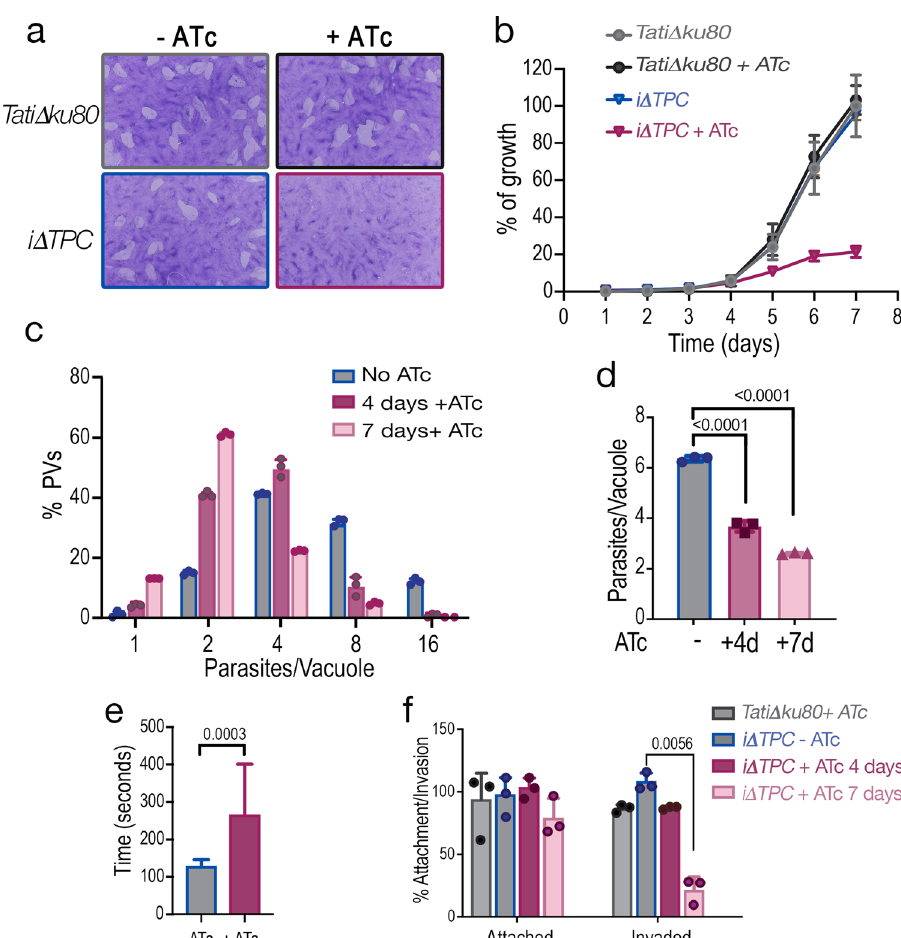
Fig. 4 Downregulation of the TgTPC disrupts every step of the Toxoplasma lytic cycle. a Plaque assays of the i Δ TPC parasites cultured in the presence of 0.5 µ g/ml Anhydrotetracycline ( + ATc). Con fl uent fi broblast cells grown in 6 well plates were infected with 150 tachyzoites of the indicated cell lines for 8 days in medium ± ATc. b Growth of Tati Δ ku80 , and i Δ TPC in fi broblasts. All parasite lines express tdTomato (a red fl uorescent protein) and were isolated as described in the Methods section. 1000 tdTomato expressing cells were used to infect each well of a 96 well plate. A standard curve for each cell line was developed for fl uorescence vs. number of parasites. Growth of parental lines is shown as control: Tati Δ ku80 without ( gray ) and + ATc ( dark gray ). Growth of i Δ TPC is shown without ( blue ) and + ATc ( magenta ). N = 3. c Growth kinetics evaluated by counting number of parasites per parasitophorous vacuole (PVs). Percentage of PVs with 1, 2, 4, 8, and 16 parasites for each cell line at 24 h post-infection was plotted. N = 3. d Average number of parasites/PV 24 h post-infection at 4 days and 7 days of ATc treatment of the i Δ TPC cells. N = 3. p < 0.0001. Error bars represent the standard deviation (SD) of three biological replicates. e Parasites treated with ATc for 5 days showed delayed egress when stimulated with ionomycin. 50,000 tdTomato- expressing parasites of i Δ TPC paras i tes without ATc, or treated with 0.5 µ g/ml ATc for 4 days were used to infect hTERT cells and allowed to grow for 24 h. n = 16, N = 4. Error bars represent the standard deviation (SD) of 16 PVs. p = 0.0003, Student ’ s t test. f Invasion assays of i Δ TPC cells treated with ATc for 4 and 7 days. Attached and invaded parasites from each cell line were normalized to the invasion of the Tati Δ ku80 cells without ATc treatment (100%). N = 3, p = 0.0056, Student ’ s t test. Data are presented as mean ± SD for ( b – f ). p value: unpaired two tailed t test performed in all